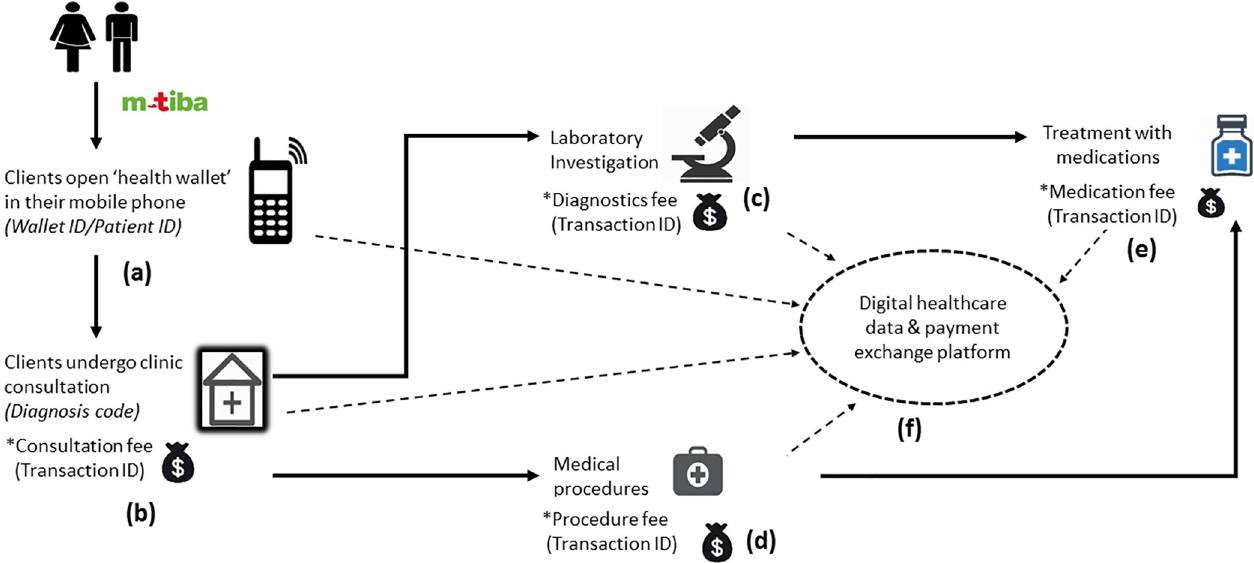
Fig 1. Diagram showing the digital healthcare exchange platform used to record patient information and to channel healthcare payments.